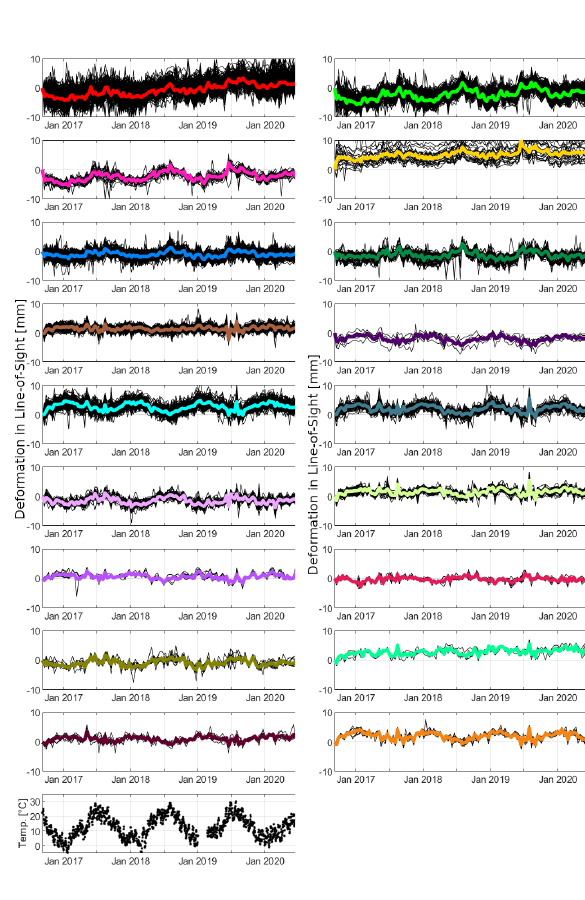
Figure 9. Time series of clusters on building A. The center point of each cluster is plotted in color. The colors correspond to the clusters in Figure 8. The bottom plot shows the mean daily